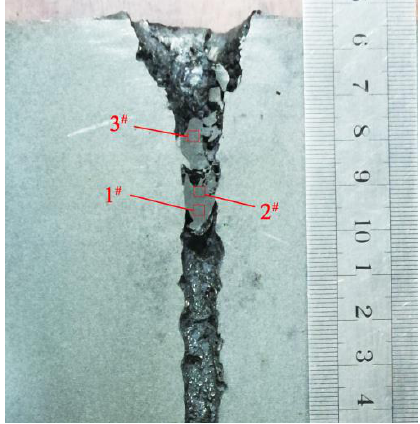
Figure 18. The fragments of Mo-10Ta alloy slug.